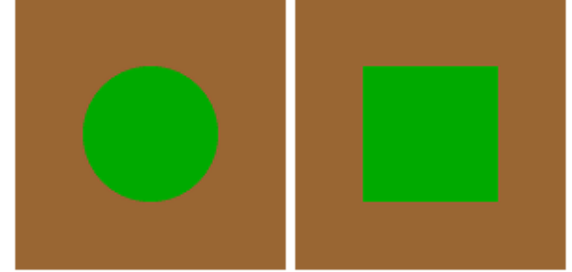
Figure 3. A circle and a square shaped forest in the same extent and resolution, 400 x 400 cells.